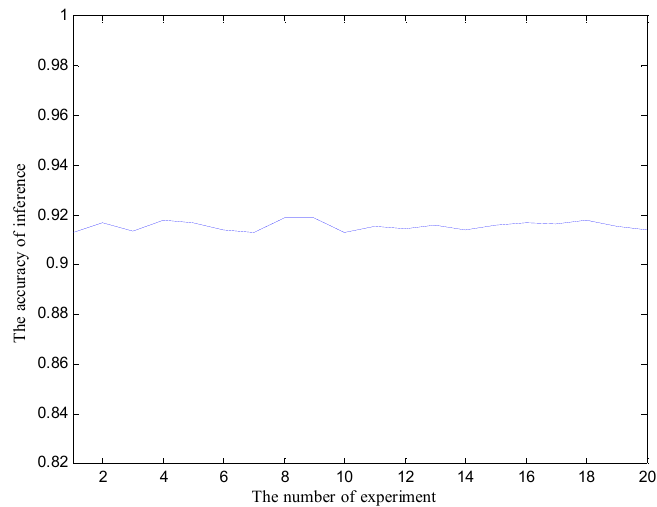
Figure 11. The accuracy of inference based on the BLMKM algorithm modeling.